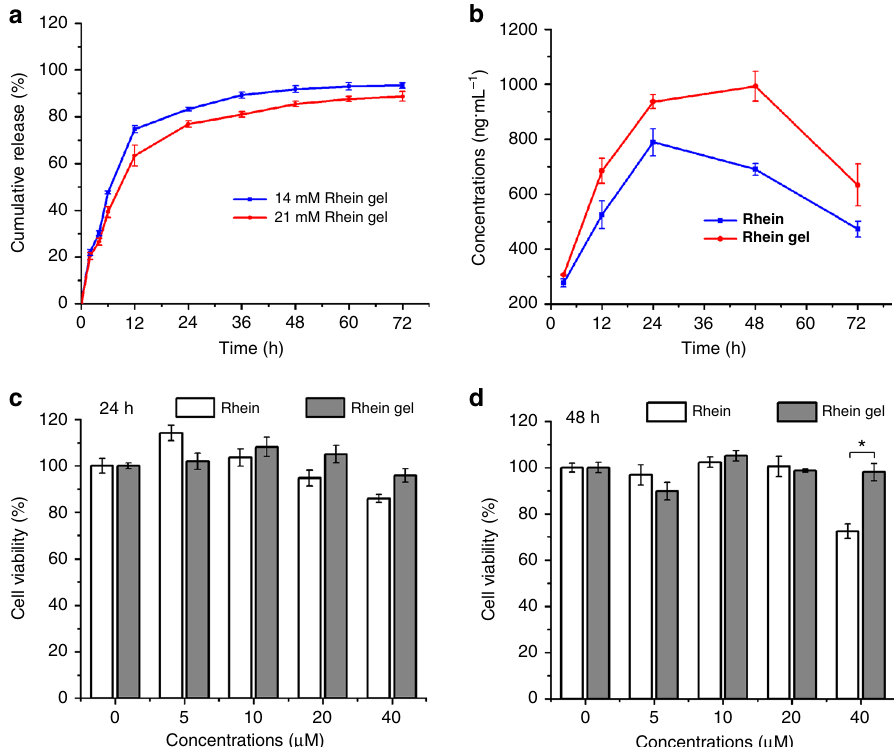
Fig. 4 Rhein hydrogel performed better sustainable release and lower cytotoxicity. a In vitro release pro fi les of rhein hydrogel, the concentrations of rhein hydrogel were 4 mg mL − 1 (14.1 mM) and 6 mg mL − 1 (21.1 mM), respectively. The gels were incubated with PBS buffer solution (pH 7.4) at 37 °C. b The curve of the concentration of rhein in the cells over time. c , d Cell viability (24 h and 48 h) of BV2 cells incubated with different concentrations of rhein hydrogel and rhein, the concentrations of the samples range from 0 to 40 μ M. Values are expressed as the means± SEM ( n = 3). One-way ANOVA with Tukey ’ s post hoc test. * p < 0.05. Error bars represent